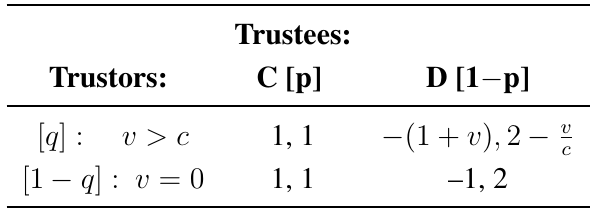
Table 1. Trustors’ (row) and Trustees’ (column) Material Payoffs.